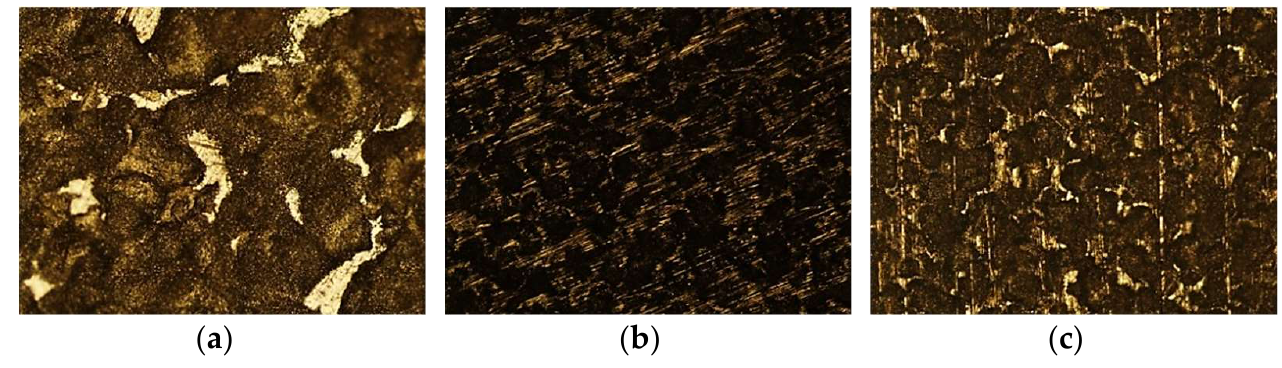
Figure 5. Optical microscope image of the Duplex 14452 sample at a magnification of 100×: ( a ) before immersion, ( b ) after three weeks, ( c ) after three months.